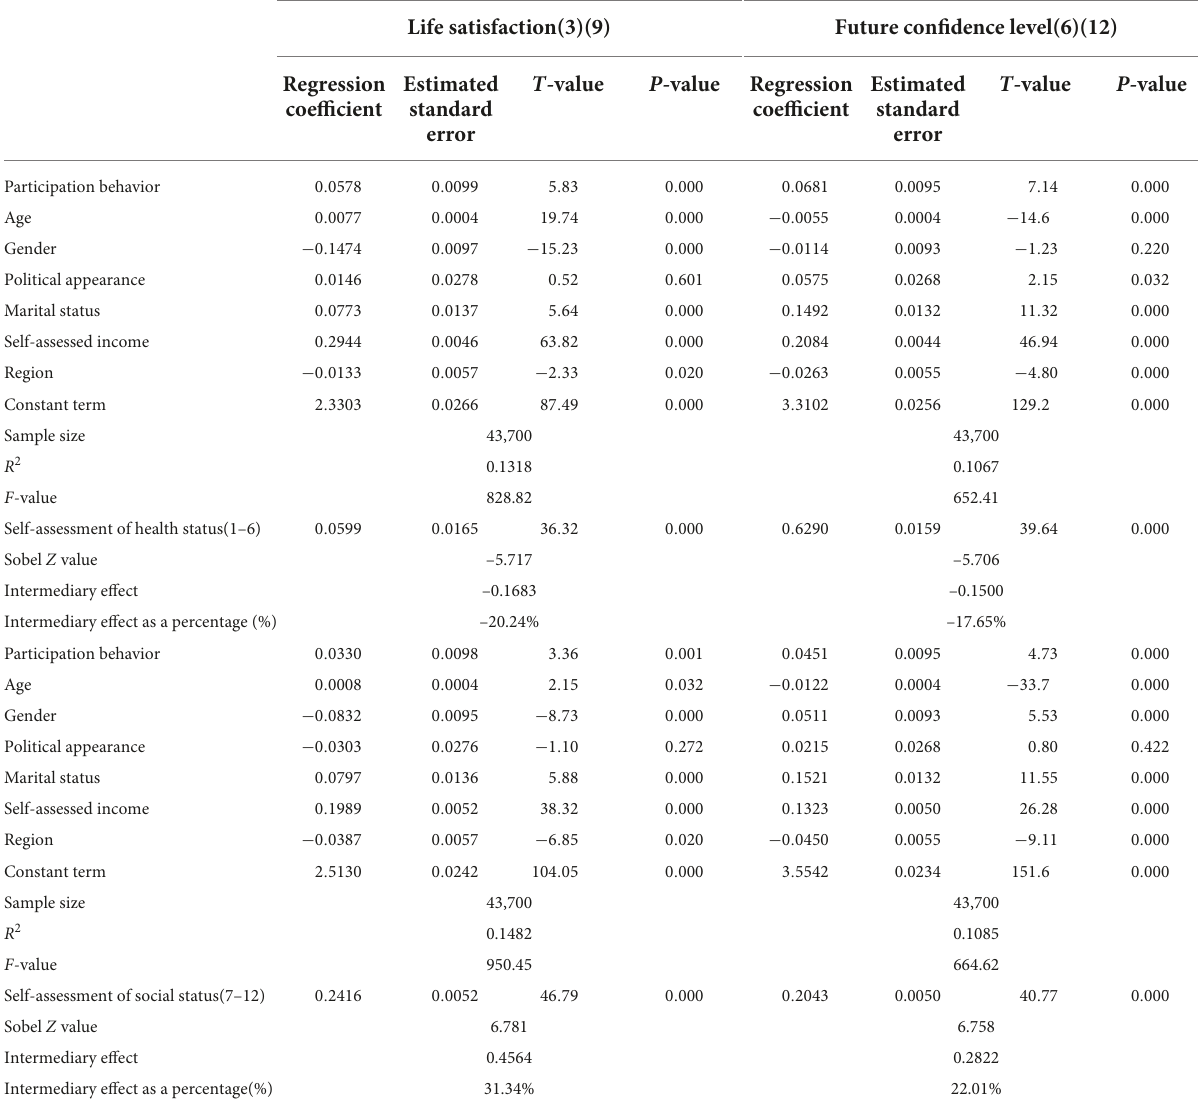
TABLE 7 Table of results of Sobel’s mediating effect